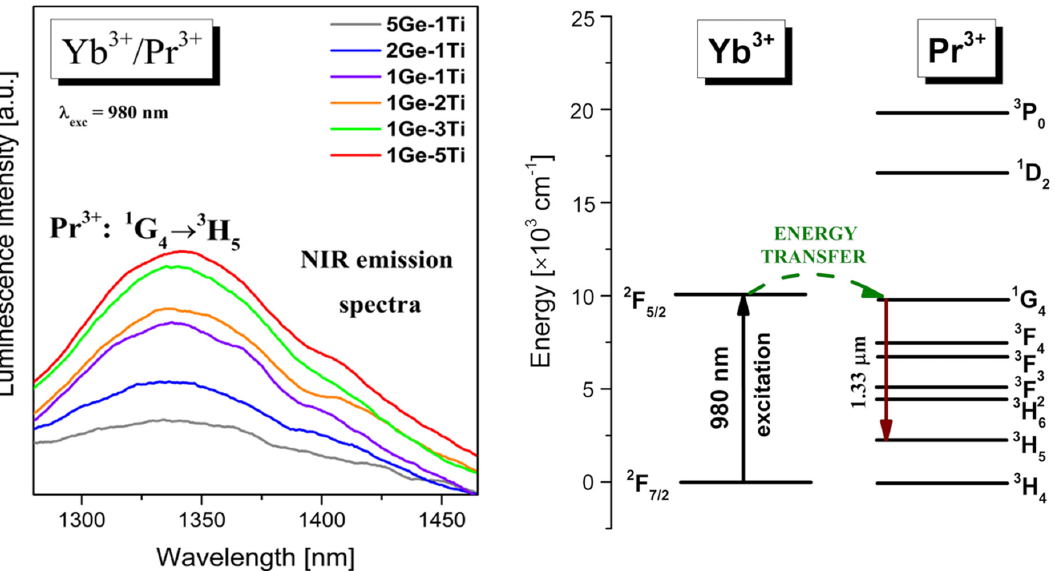
Figure 2. Near ‐ infrared emission spectra and energy level diagram for titanate–germanate glasses co ‐ doped with Yb 3+ /Pr 3+ . The observed near ‐ IR emission bands at about 1.35 μ m correspond to 1 G 4 → 3 H 5 tran ‐ sition of Pr 3+ . It should be particularly pointed out that the emission intensities of Pr 3+ ions increased significantly with increasing TiO 2 concentration from 5Ge ‐ 1Ti to 1Ge ‐ 5Ti.